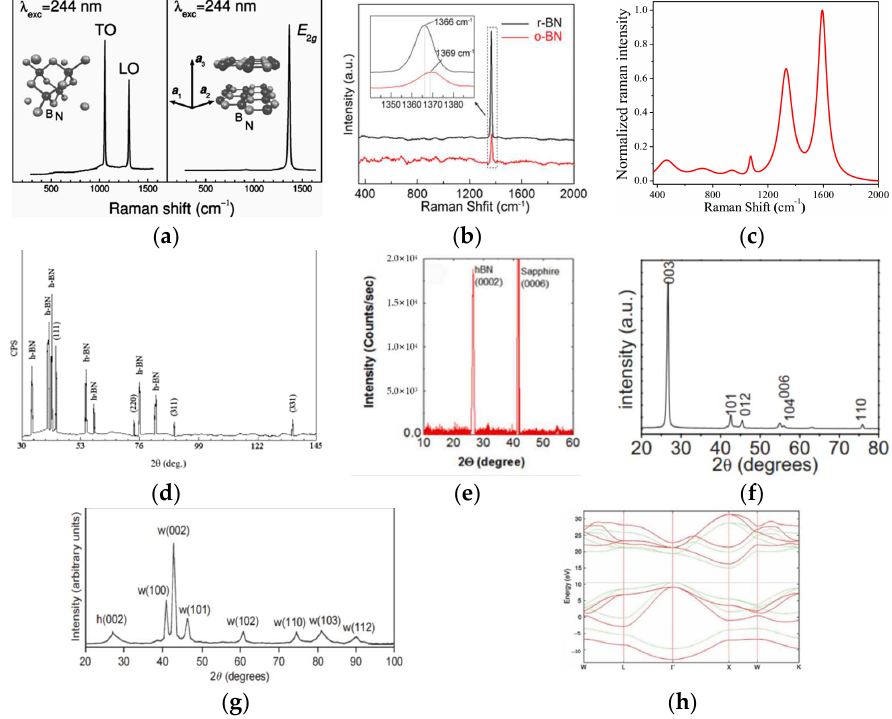
Figure 3. Raman for c-BN ( a ) left [18], h-BN ( a ) right [18], r-BN ( b ) [19], w-BN ( c ) [20]. XRD for c-BN ( d ) [21], h-BN ( e ) [14], r-BN ( f ) [22], w-BN ( g ) [23]. ( h ) Band structure of h-BN along the high symmetry directions